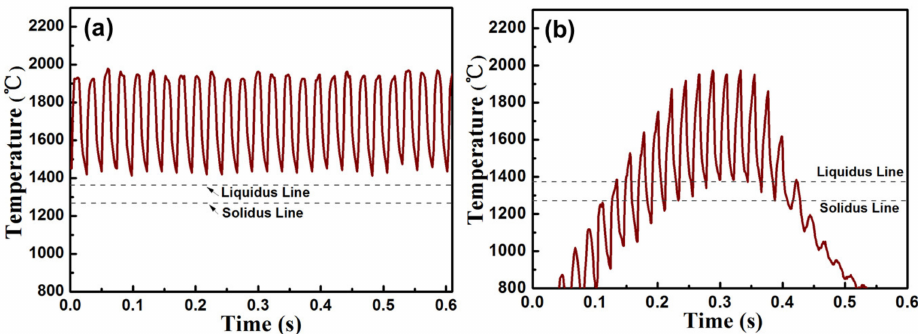
Figure 7. Temperature variations of the molten pool during QCW-LAM: ( a ) Transient temperature curve and ( b ) fixed-point temperature